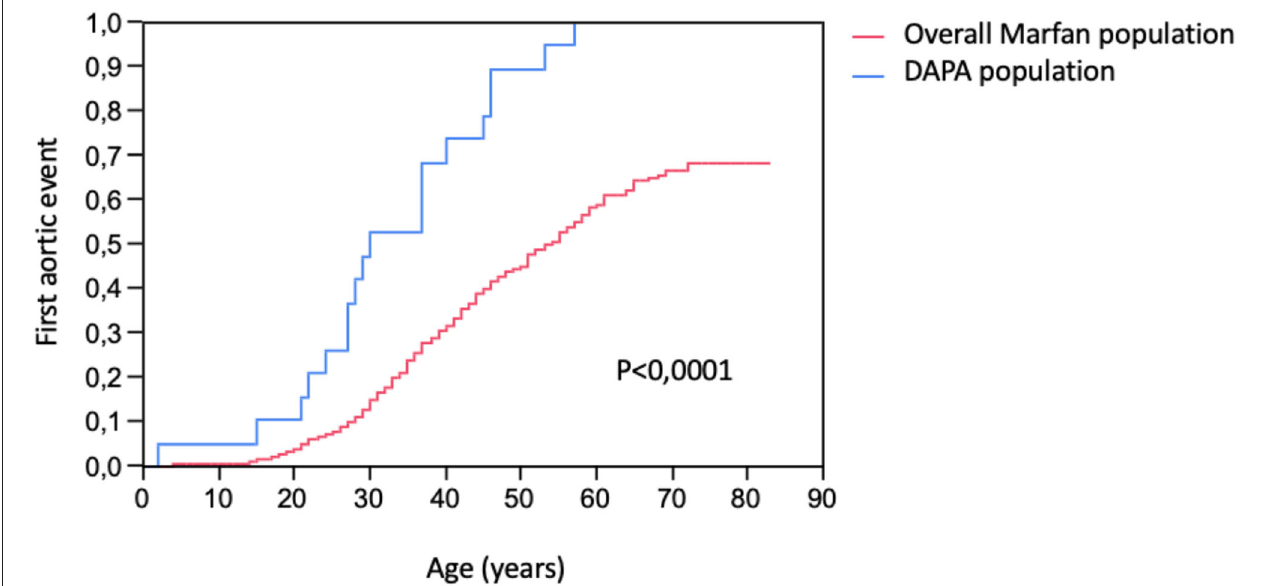
FIGURE 2 | Kaplan–Meier estimation of first aortic events (ascending and distal aortic aneurysm surgery or aortic dissection) occurrence in DAPA (distal aortic and peripheral aneurysm) population and in the overall population of patients with Marfan syndrome with FBN-1 mutation.